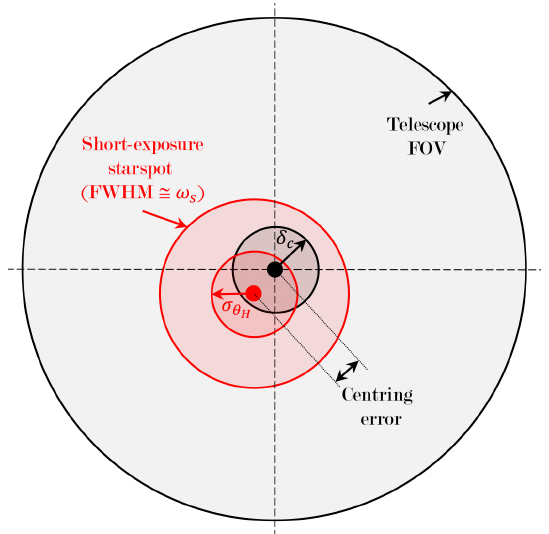
Figure C1. Schematic of one possible position and size of the short- exposure starspot (bright red) relative to the SBIG camera CCD grid (dashed lines), for the case δ c = σ θ . The telescope FOV is shown H in black: its centre (solid black circle) nominally defines the ori- gin of the SBIG camera grid. We define the “centring error” as the distance between the centre of the (black) telescope FOV and the centre of the (red) short-exposure starspot.